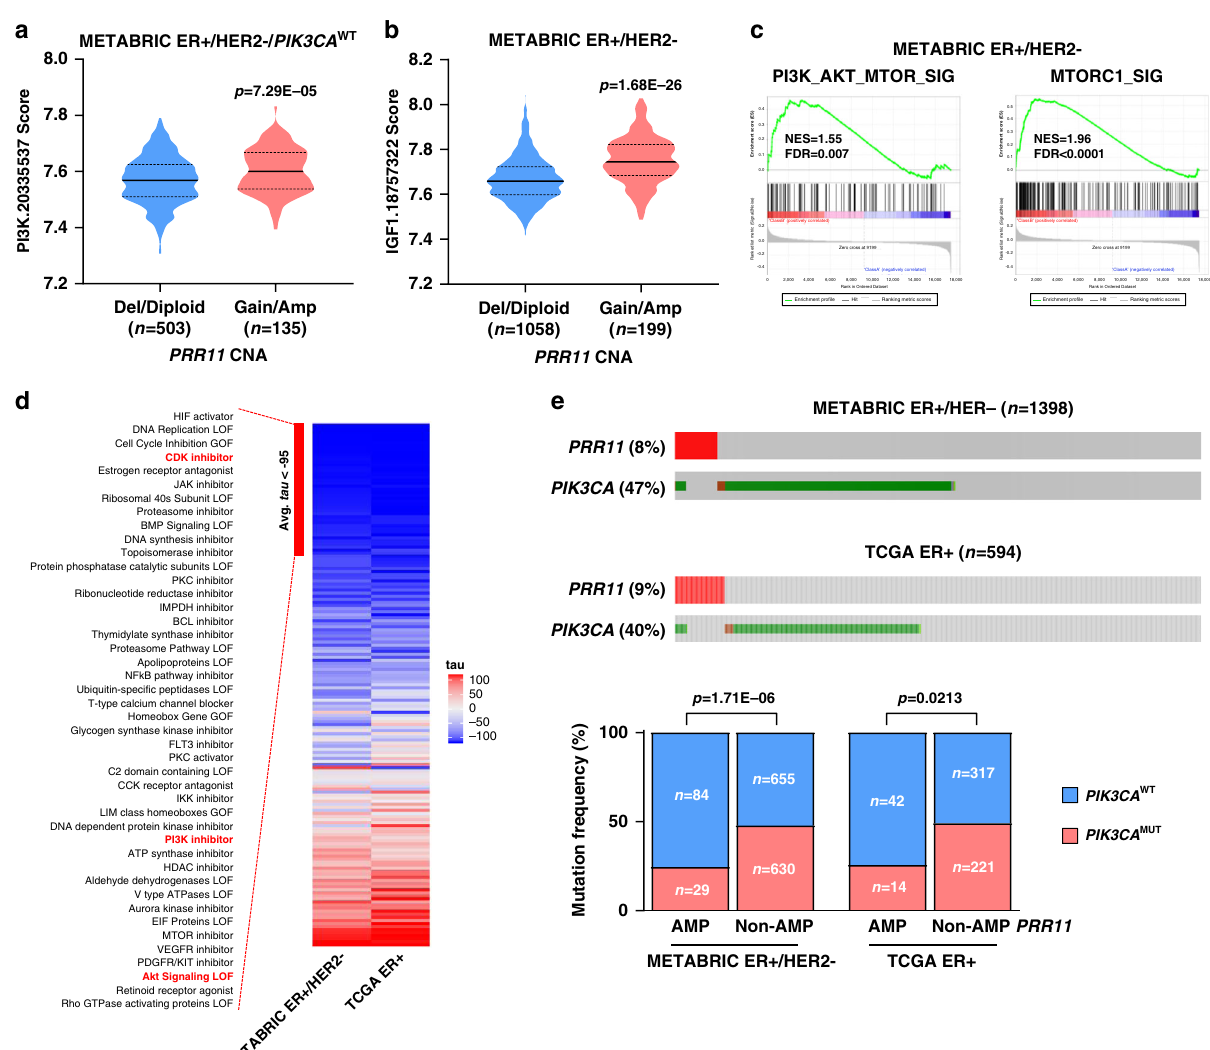
Fig. 6 PRR11 ampli fi cation is associated with hyperactivation of the PI3K pathway in ER + breast cancers. a , b Signature score of the PI3K gene set in ER + /HER2 − / PIK3CA wild type breast cancers in METABRIC plotted as a function of PRR11 copy number ( a : n = 503 and 135 for deletion/diploid and gain/ ampli fi cation group, respectively). Signature score of IGF1 gene set in ER + /HER2 - breast cancers in METABRIC plotted as a function of PRR11 copy number ( b : n = 1058 and 199 for deletion/diploid and gain/ampli fi cation group, respectively). Data represent the mean ± SD (two-tailed unpaired t -tests). c GSEA of mRNA expression data from ER + /HER2 - tumors in METABRIC ( PRR11 gain/ampli fi cation vs deletion/diploid); analyses show enrichment in PI3K_AKT_MTOR_SIG and MTORC1_SIG signatures. d Connectivity scores ( tau ) were computed using the connectivity map (CMap) with genes signi fi cantly upregulated in ER + (TCGA) breast cancers harboring PRR11 ampli fi cation vs. no ampli fi cation and ER + /HER2 − (METABRIC) breast cancers with PRR11 gain/ampli fi cation vs. PRR11 deletion/diploid. Connectivity score of 44 perturbation classes out of 171 are highlighted ( tau < – 95). e PIK3CA mutation frequency in ER + /HER2 − (METABRIC : n = 1398) and ER + (TCGA: n = 594) breast cancers plotted as a function of PRR11 copy number alterations vs. no alterations (two-tailed Fisher ’ s exact test). Source data are provided as a Source data fi Methods Cell lines . The MCF7 (ATCC ® HTB-22), HCC1428 (ATCC ® CRL-2327), MDA- MB-175-VII (ATCC ® HTB-25) and MDA-MB-134VI (ATCC ® HTB-23), BT-474 (ATCC ® HTB-20) human breast cancer cells, HEK293 (ATCC ® CRL-1573) human embryonic kidney cells and MCF10A (ATCC ® CRL-10317) breast epithelial cells